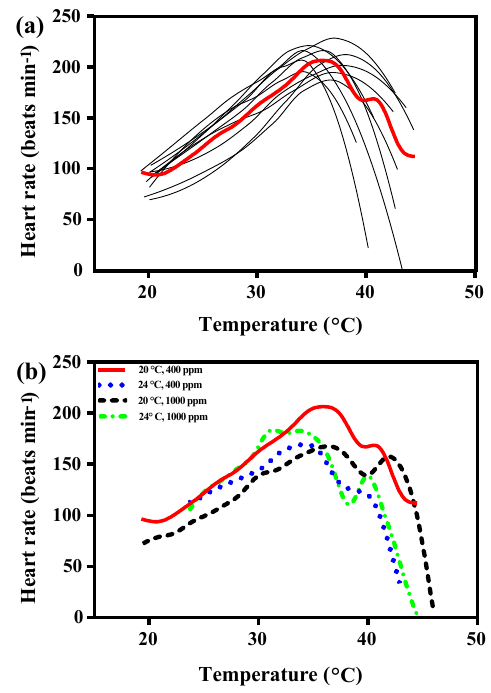
Figure 1. (a) Heart rates of all limpets acclimated to 20 ◦ C and 400ppm, presented as an example of heart rate calculation for limpets in all treatments. The black lines correspond to smoothed fits (using the loess algorithm) of heart rates for each of the individ- ual limpets. The red line represents the most likely general additive mixed model (GAMM) to depict the trajectory of heart rates for limpets with increasing temperature; (b) GAMM lines of limpets acclimated at the different experimental temperature and CO 2 con-